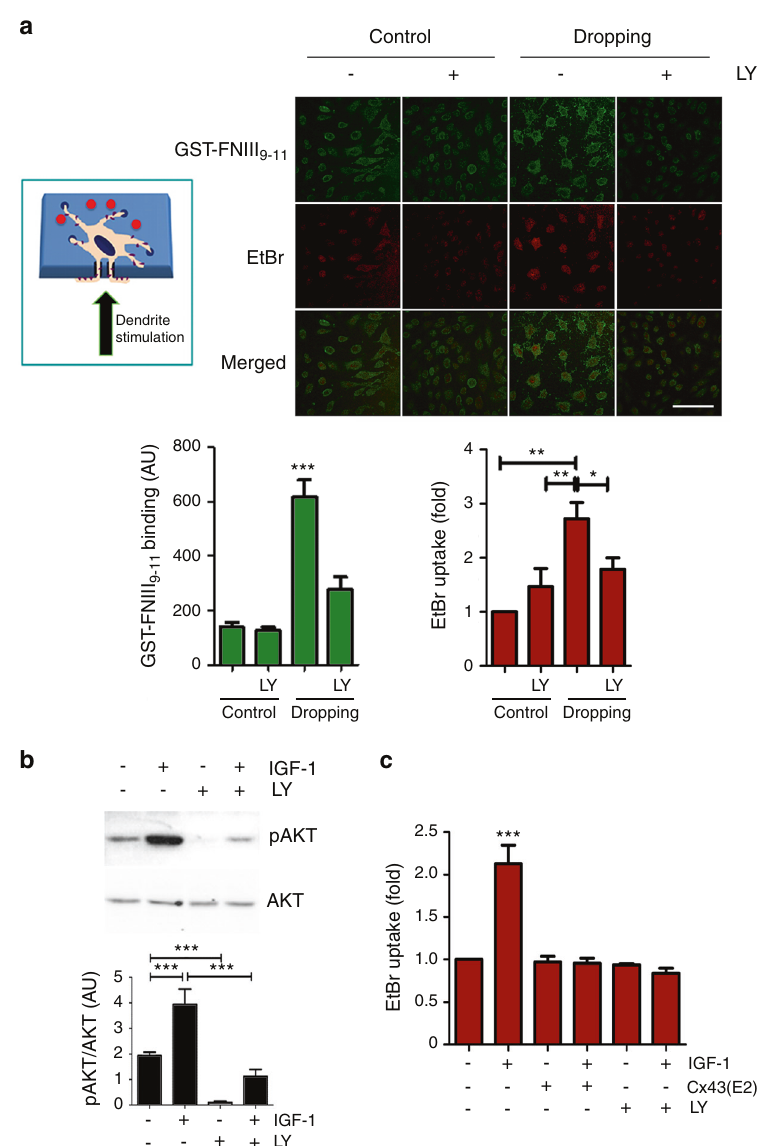
Fig. 2 Activation of PI3K by mechanical loading is essential for HC opening. a Inhibition of PI3K signaling prevents the activation of α 5 β 1 and the opening of HCs by mechanical loading. MLO-Y4 cells preincubated with or without 10 μ mol·L − 1 LY294002 (LY) for 15 min were subjected to mechanical loading by liquid dropping with 50 μ mol·L − 1 EtBr solution to the dendritic process side of the transwell fi lter (upper left panel). The cell body side of the transwell fi lter was then incubated with the GST-FNIII 9-11 fragment. The confocal fl uorescence images were taken; green fl uorescence indicates binding of the GST-FNIII 9-11 fragment, and red fl uorescence indicates the uptake of EtBr (upper right panel). The extents of α 5 activation (lower left panel) and HC opening (lower right panel) were determined based on GST-FNIII 9-11 binding and EtBr uptake, respectively. Bar, 100 µm. Cells under dropping versus all other treatments, *, P < 0.05; **, P < 0.01; ***, P < 0.001. b Activation of PI3K- AKT by IGF-1 in osteocytes. MLO-Y4 cells were pretreated with or without LY and then incubated with 5 ng·mL − 1 IGF-1 for 30 min. Cell lysates were immunoblotted with an anti-phospho-AKT (Ser473) (pAKT) or total AKT antibody. The band intensity and the ratio of phosphorylated to total AKT were quanti fi ed (lower panel). c The opening of HCs requires PI3K activation. MLO-Y4 cells were pretreated with or without LY or a Cx43(E2) antibody for 15 min and then incubated with 5 ng·mL − 1 IGF-1. HC activity was then measured by EtBr dye uptake. All data are presented as the mean ± SEM. n = 3. Cells treated with only IGF-1 versus all other treatments and control, ***, P < sense mechanical stress and play a critical role in skeletal magnitudes. Together, our data from in vitro cell studies and adaptation and anabolic responses to loading. 8 In this study, we in vivo mouse transgenic models with tibial loading showed that the activation of dendritic α V β 3 by mechanical loading transmits show that integrin α V β 3, located at the dendritic processes of the signals to α 5 β 1 on the cell body, leading to HC opening. osteocytes, serves as a distal mechanical sensor of osteocytes. As illustrated in Fig. 6b, activation of integrin α V transmits signals to the cell body to open HCs. This intracellular mechanotransduction pathway is mediated through the activation of intracellular PI3K- DISCUSSION AKT signaling. The transmission of the signals to the cell body Osteocytes with extensive, long dendritic processes and a fl uid- fi lled lacunae-canaliculi system are well positioned in the bone to activates integrin α 5 β 1 and consequently opens Cx43 HCs. We